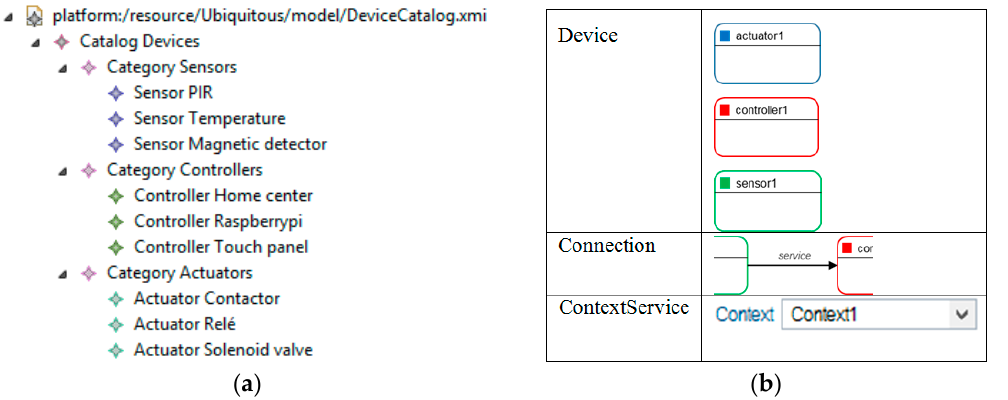
Figure 2. Concrete syntax of Smart City DSL. ( a ) extract of the device catalog; ( b ) graphic representation of main